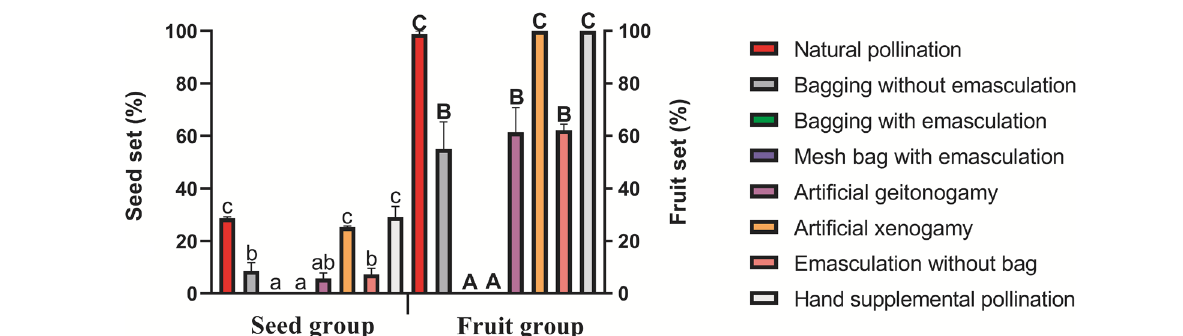
Fig. 1 Seed set (%) and fruit set (%) of different pollination treatments in P. decomposita . Bars are means and vertical lines above bars are standard errors. The significant difference of seed set and fruit set were indicated in lowercase and bold capital,